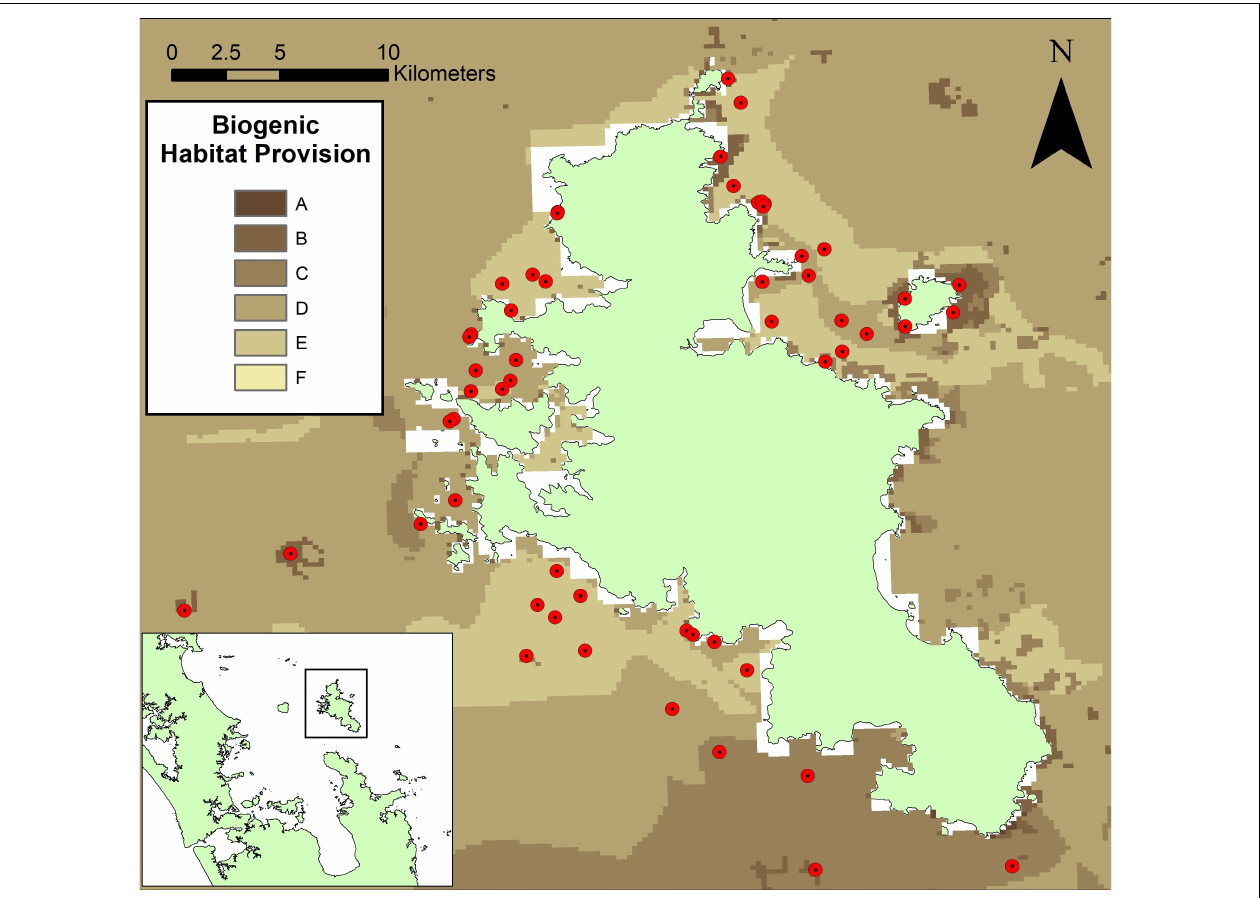
FIGURE 2 | Sites selected for empirical assessment (red dots) around Great Barrier Island, New Zealand, superimposed on the ecosystem service map of biogenic habitat. Sites cover a range of map scores and sediment types and are situated around the island. White spaces close to the shore indicate where biogenic habitat scores could not be calculated. This is due to an absence of data from one or more principle layers in the near shore environment.